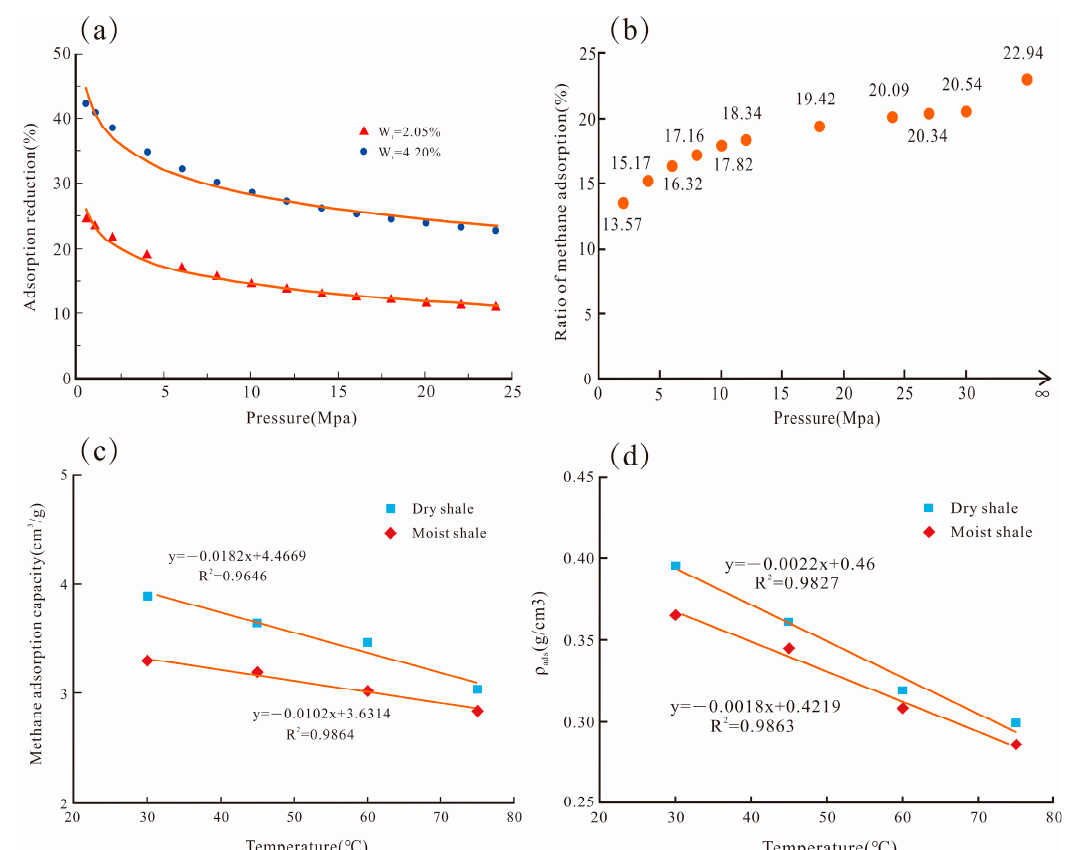
Figure 10. Effects of temperature and pressure on the methane adsorption capacity of shales under dry and moist conditions. ( a ) The relationship between pressure and the reduction percentage of the methane adsorption capacity of moist (equilibrium moisture) shale compared with dry shale. The moisture contents are 2.05% and 4.20%, and the temperature is 333.15 K. The shale samples are from the Longmaxi formation in the Pengshui Block, eastern Sichuan, China. The figure is from [202]. ( b ) The relationship between pressure and the percentage of the methane adsorption capacity of shale containing equilibrium moisture relative to dry samples. The moisture content is 1.15%, and the temperature is 303.15 K. Upper Ordovician shale from the western part of the Ordos Basin, China. The figure is from [203]. ( c , d ) The relationship of temperature with the methane adsorption capacity and adsorption phase density ( ρ ads) of shale under dry and moist (connate water) conditions, respectively. Carboniferous coal-measure shale in the Yangquan block, Qinshui Basin, China. The figures are modified from